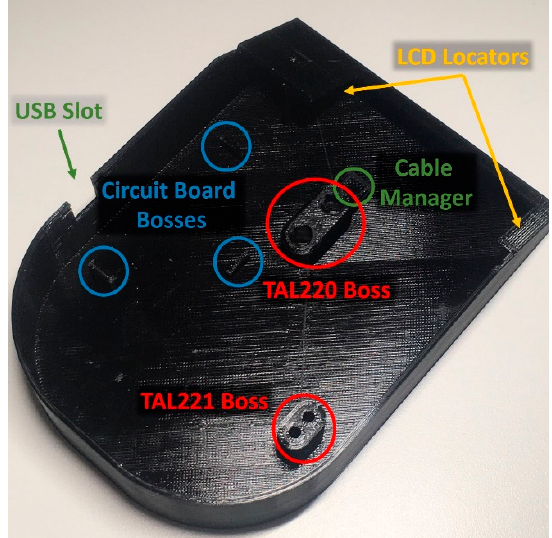
Figure 4. Key features of the base include standoffs to mount the load cell, locators for the screen and circuit board, and a slot for access to the Arduino Nano’s USB port. The base also has a snap-seam to attach the cover to the base, enclosing the internal components.